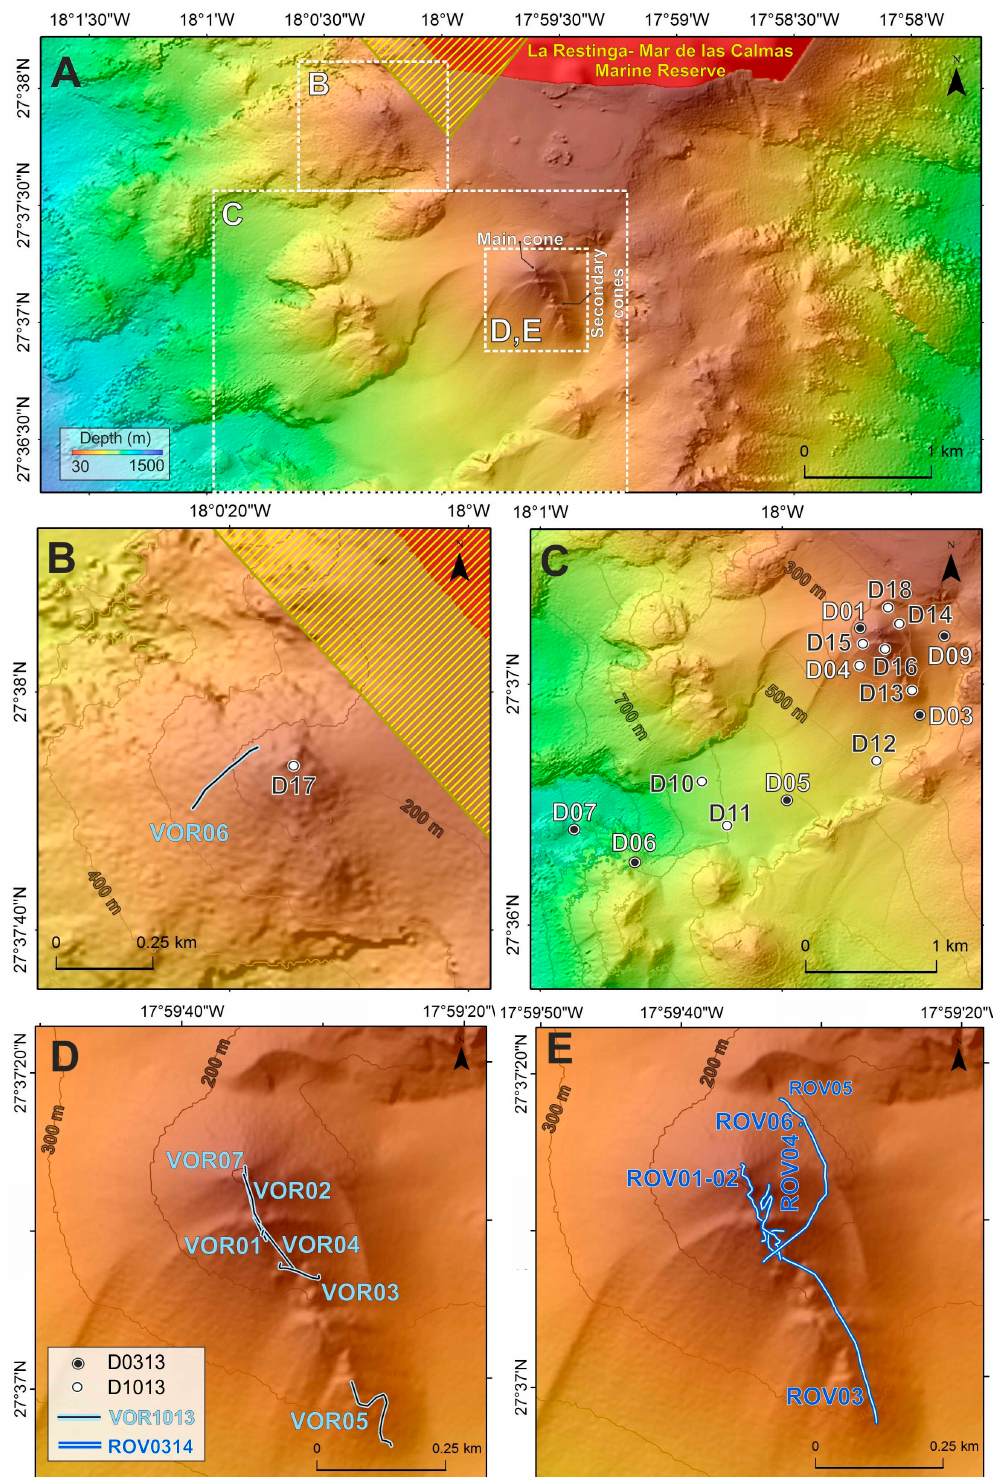
Figure 3. Sampling strategy ( A ) Bathymetric map showing south of El Hierro Island where the different sampling areas ( B–E ) are highlighted. ( B ) Unaffected eruption area close to the La Restinga-Mar de las Calmas Marine Reserve. ( C ) Tagoro volcanic complex, and ( D , E ) Main edifice and secondary cones of the Tagoro volcano. Dots represent dredge sites during the VULCANO0313 (black dots), and VULCANO1013 (white dots) oceanographic cruises. Lines indicate vehicle operated remotely (VOR) Aphia, (light blue) and remote operated vehicle (ROV) Liropus (dark blue double line) transects during the Vulcano1013 and Vulcano0314 oceanographic cruises.